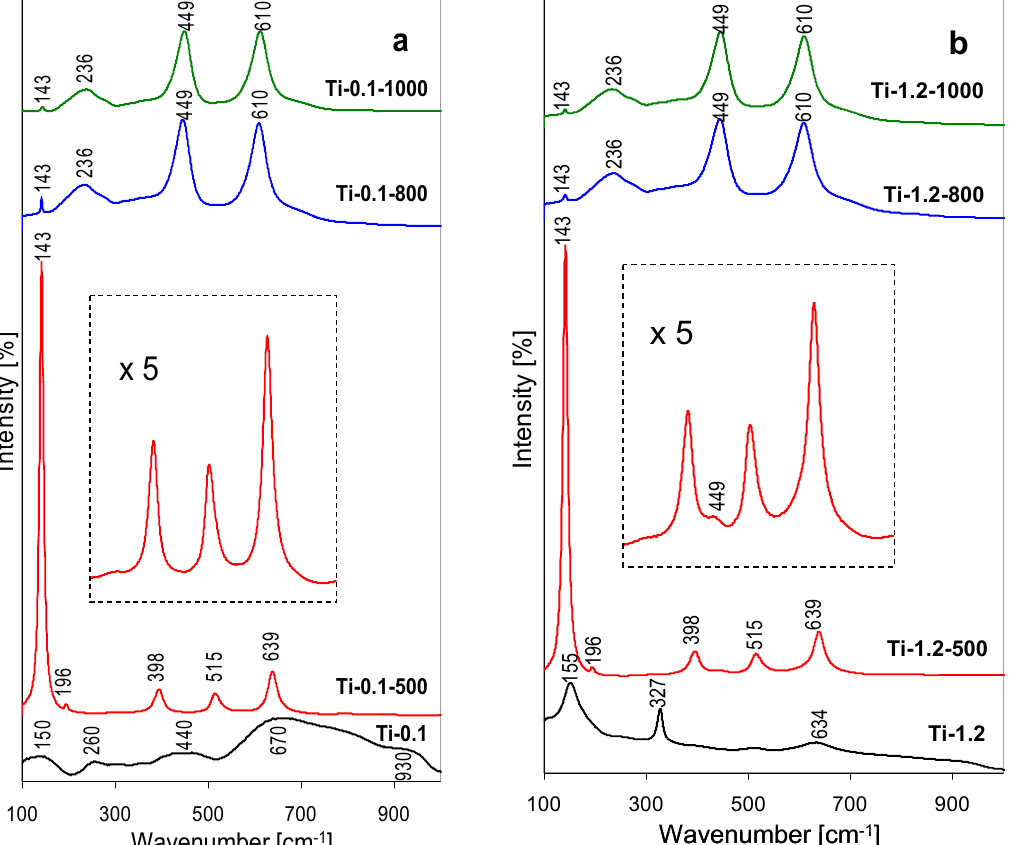
Figure 2. Raman spectra illustrating the effect of thermal treatment on hydrolysates obtained by lyophilization of Ti-pillaring solution: ( a ) As received at pH = 0.1, ( b ) after pH adjustment to 1.2. The spectrum of Ti-1.2 precipitate, obtained from the pillaring solution after pH adjustment, shows better resolved features. The set of bands at 155, 327 and 634 cm − 1 points to the formation ill-defined broad bands, centered around 150, 260, 440, 670, 930 cm − 1 . All, except the first one, may be considered as envelopes of broadened bands stemming from amorphized lepidocrocite-type titanate phase [18], whose presence has been suggested on the base of the XRD pattern (Figure 1a).